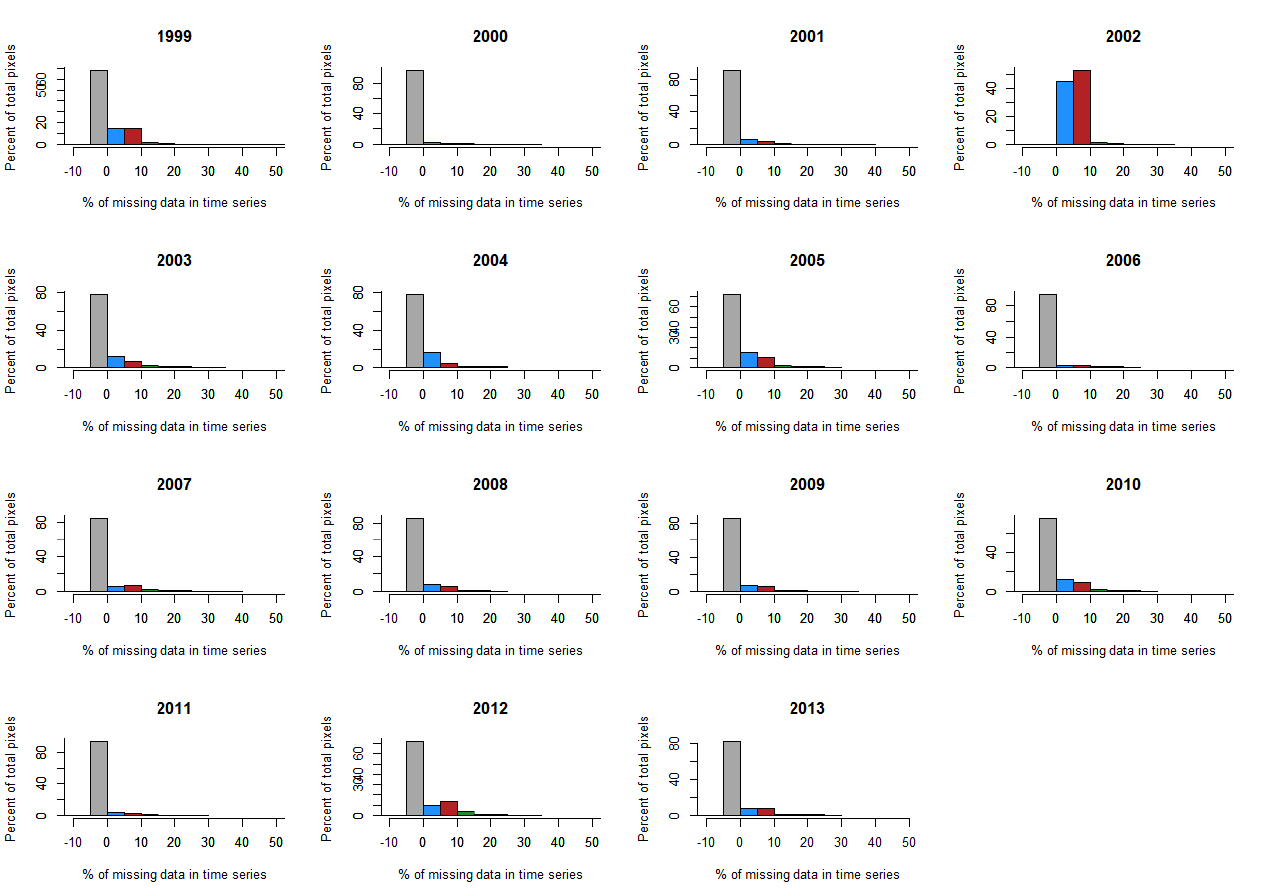
Figure A2. Histograms of percentage of missing data in yearly FAPAR time series from 1999 to